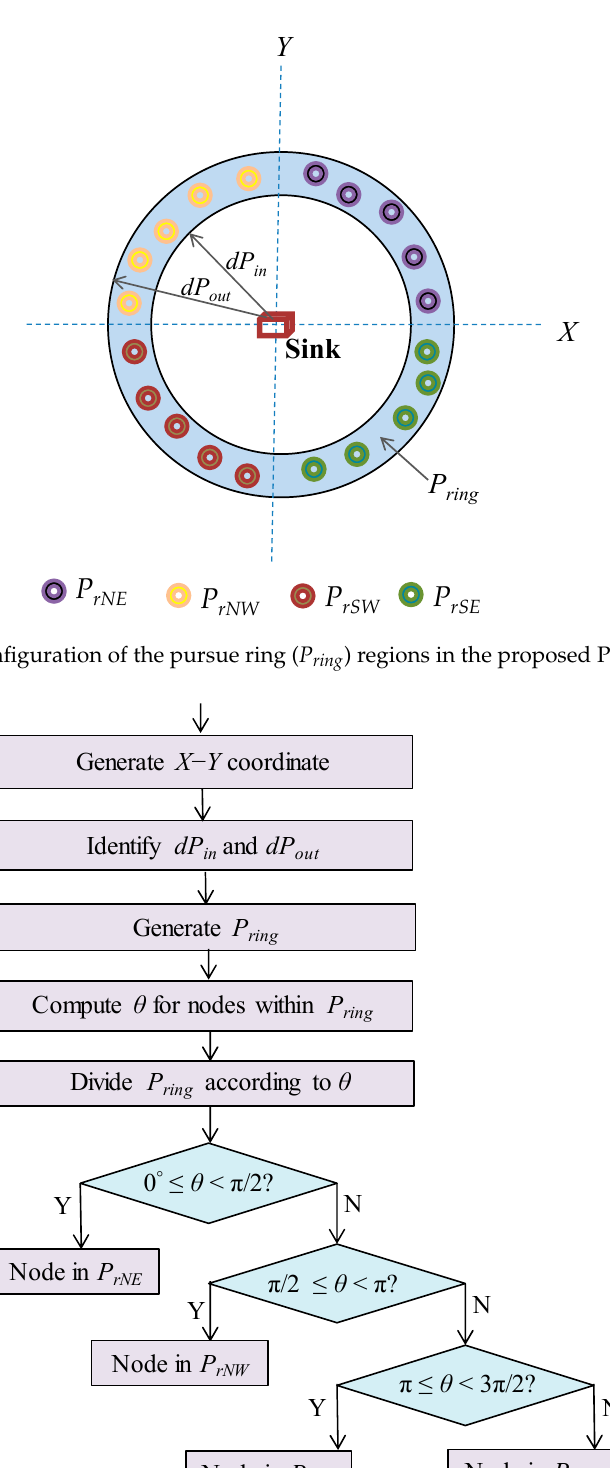
Figure 2. Flowchart of the P ring computation process in the proposed PhaP protocol.